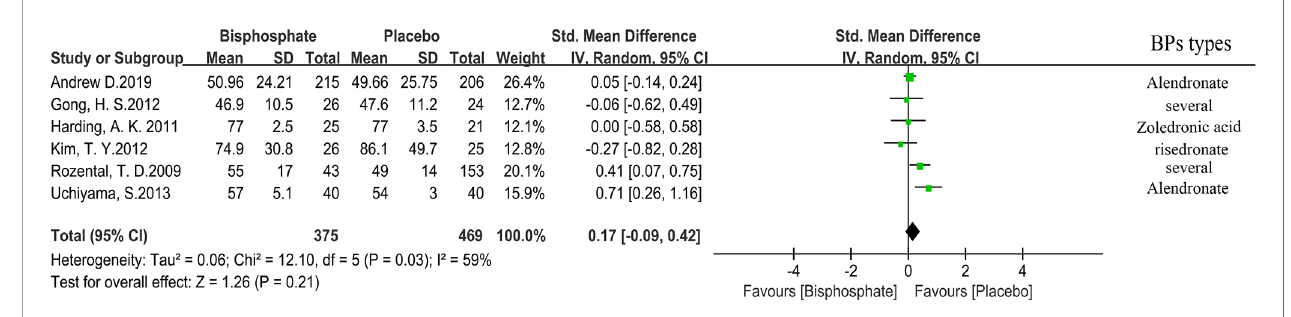
FIGURE 3 | Forest Plot of Fracture Healing time.